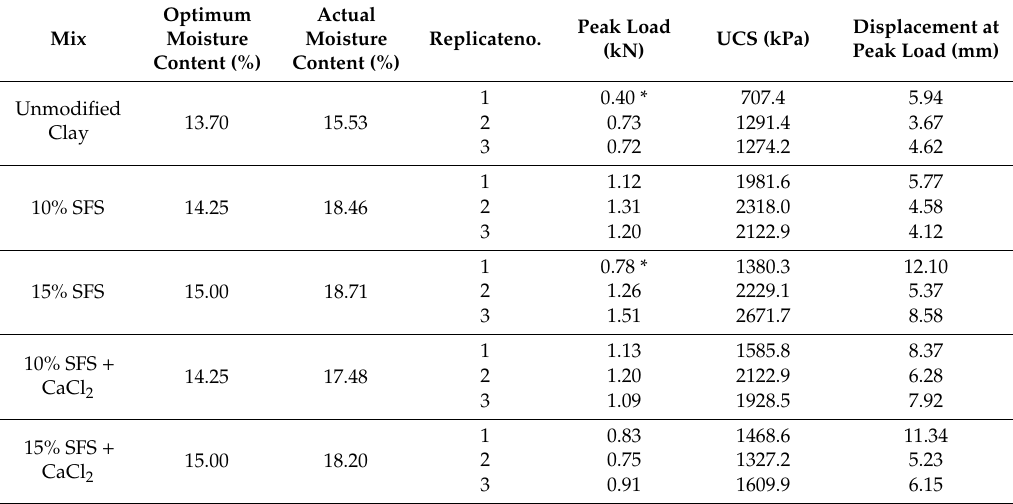
Table 8. Values of unconfined compressive strength (UCS), actual moisture, target moisture, and displacement at peak load.